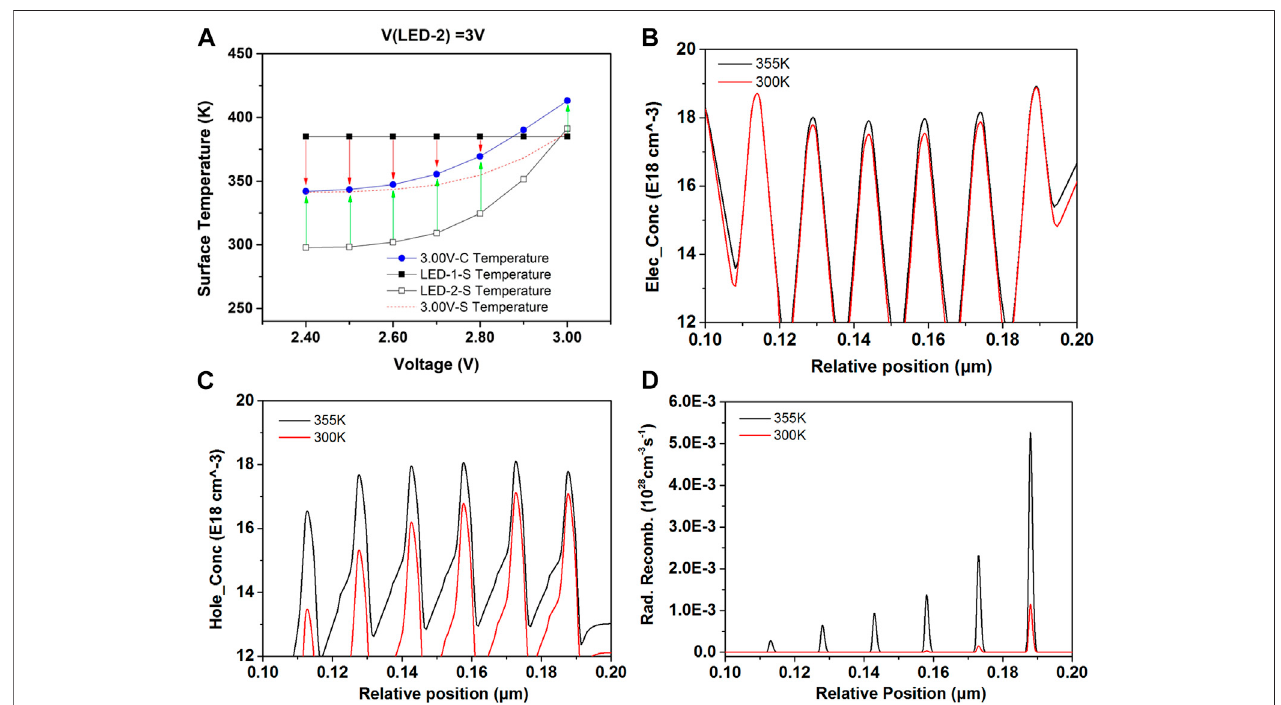
FIGURE4|(A) .ThedevicetemperatureofLEDsversusappliedvoltageforCombined-LEDsandSeparated-LEDssetupswiththevoltageofLED-2 fi xedat3.00 V. Numerical results of the (B) electron concentration, (C) hole concentration, and (D) radiative recombination rate in the InGaN/GaN LEDs with the device temperature of 300 and 355 K under the voltage of 2.6